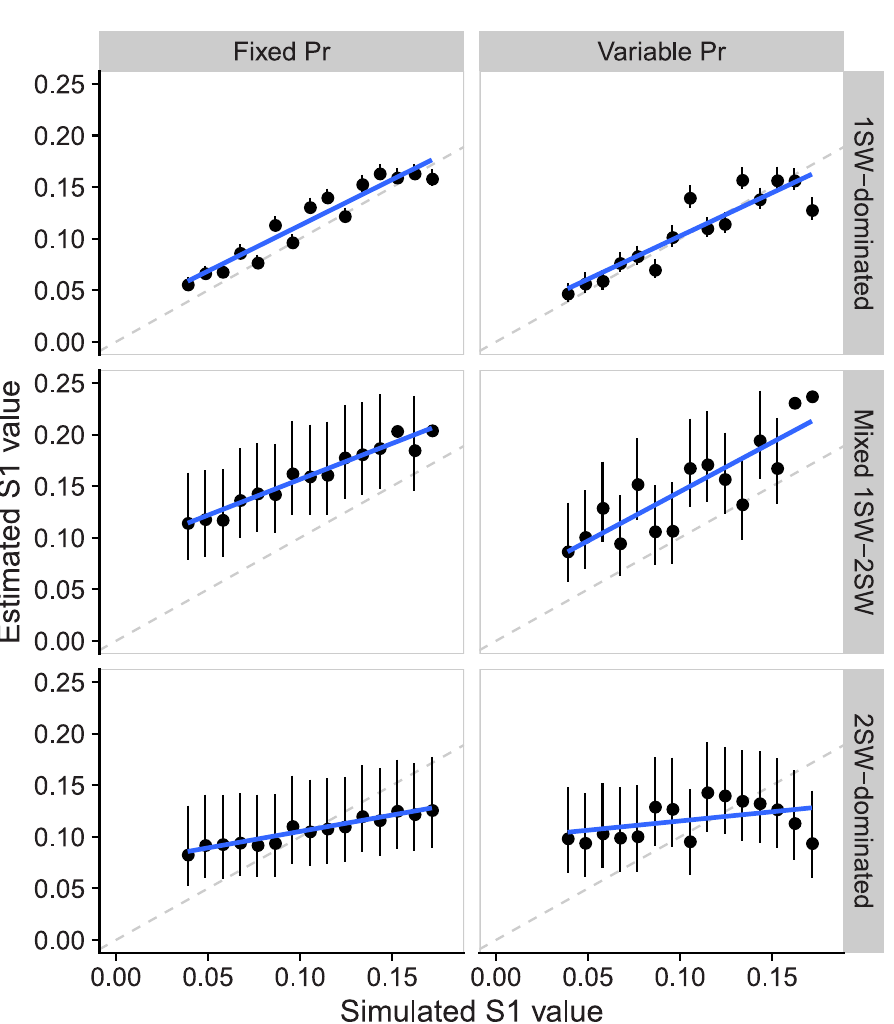
Fig 3. Comparison of estimated and true S 1 values in the six scenarios. True S 1 values are deterministic, black circles show median S 1 estimates, error bars indicate the 25% and 75% quantiles, while the blue line denotes a linear model fit of the medians. The one-to-one relationship is shown by the gray dashed line.